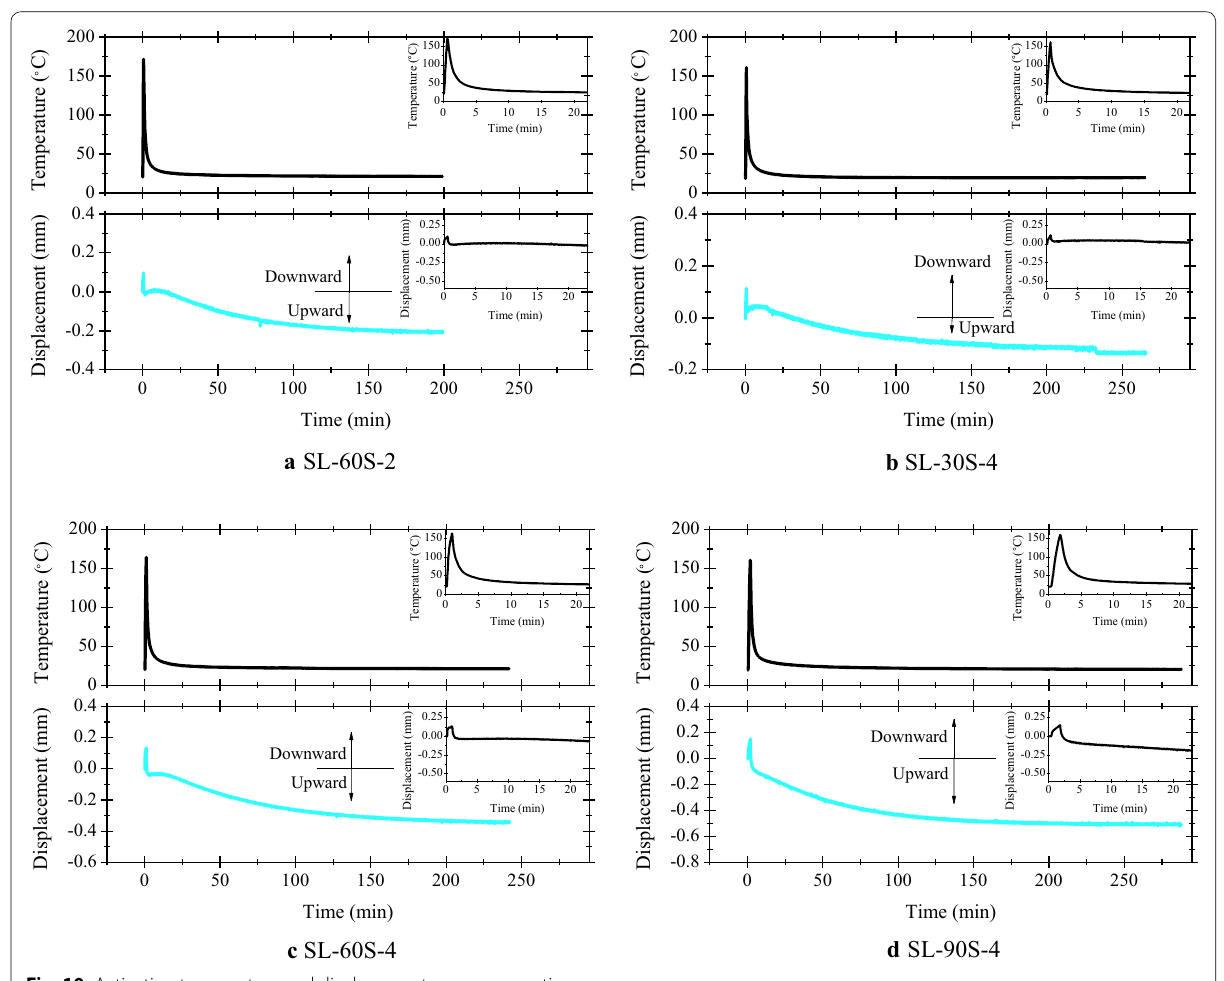
Fig. 10 Activation temperature and displacement curves across time.